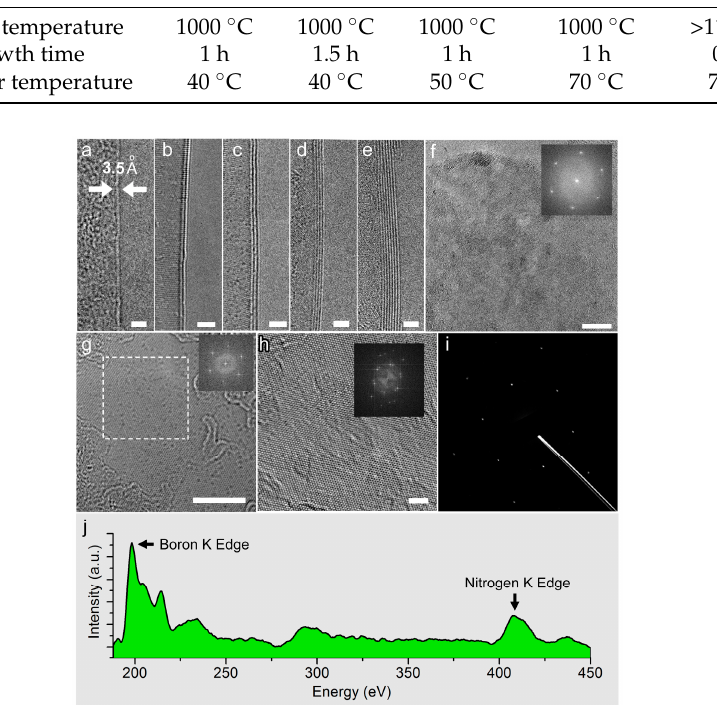
Figure 2. TEM images, diffractions and EELS of single-layered and few-layered h-BN films. ( a – e ) TEM images of single- (1 L), double- (2 L), three- (3 L), four- (4 L) and seven-layered (7 L) h-BN films, respectively. Scale bar: 2 nm; ( f ) TEM image of random area of single-layered film and its FFT pattern (inset). Scale bar: 10 nm; ( g ) HRTEM image of single-layered h-BN film and its FFT patterns from the white-dashed region. Scale bar: 5 nm; ( h ) TEM image of few-layered h-BN and its FFT patterns. Scale bar: 2 nm; ( i ) A typical diffraction pattern of few-layered h-BN in a large area; ( j ) EELS of few-layered h-BN film.